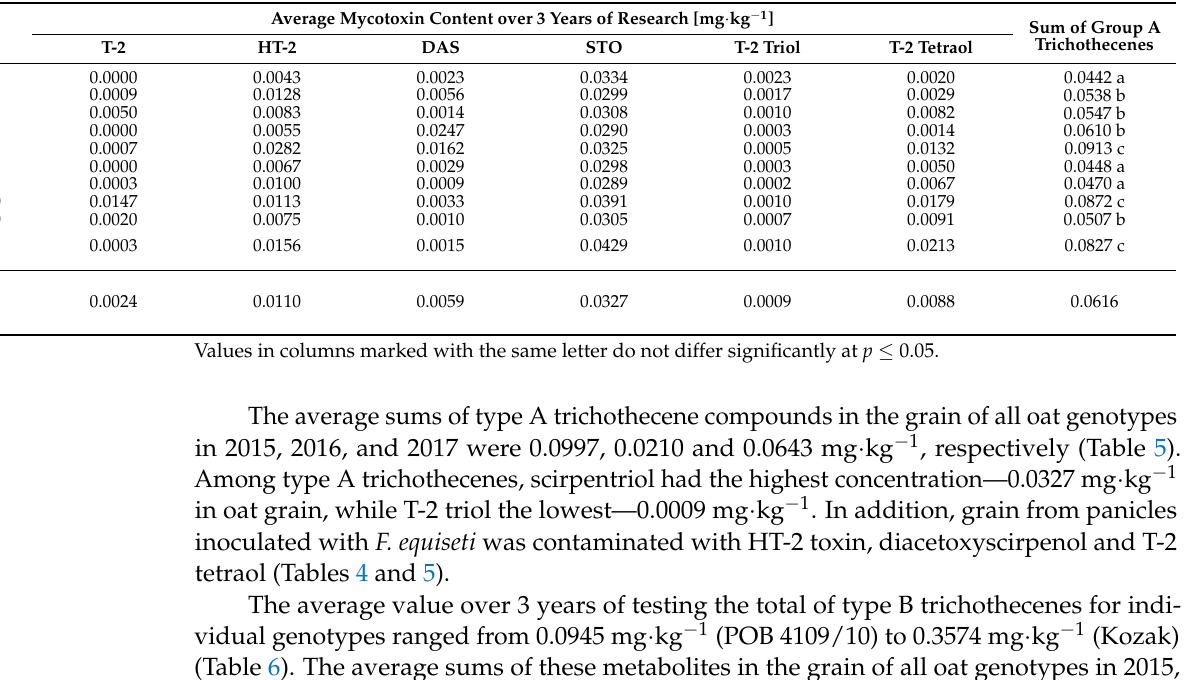
Table 4. Content of type A trichothecenes (T-2/HT-2—toxin, diacetoxyscirpenol—DAS, scirpentriol— STO, T-2 triol, T-2 tetraol) in oat kernels after panicle inoculation with F.